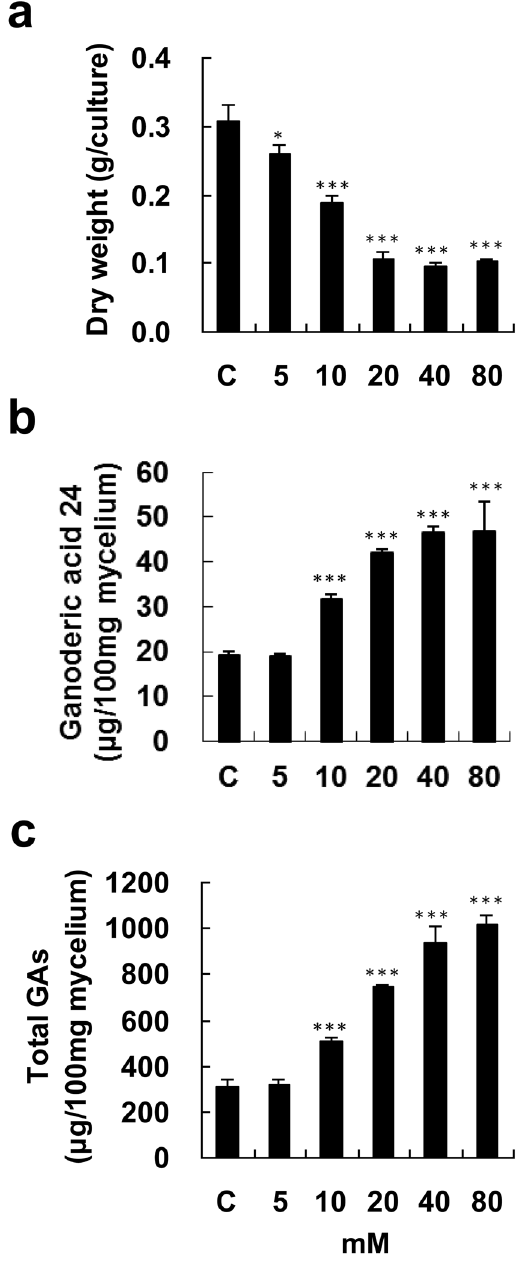
Figure 2. Effect of caffeine on fungal biomass and production of ganoderic acids in Ganoderma lucidum . Four- day-old fungal mycelium was cultured on potato dextrose agar (PDA) in 9-cm diameter petri dishes, and then incubated with 5–80 mM caffeine in 25 ml potato dextrose broth (PDB) for 4 days. Dried mycelium was used to measure fungal biomass ( a ). Both lanosta-7,9(11), 24-trien-3 α -o1-26-oic acid (ganoderic acid 24) ( b ), and total ganoderic acids (GAs) ( c ) were measured by HPLC. The means of three independent samples with standard deviations are presented. * p < 0.05, ** p < 0.01, *** p < 0.001 as compared with the control